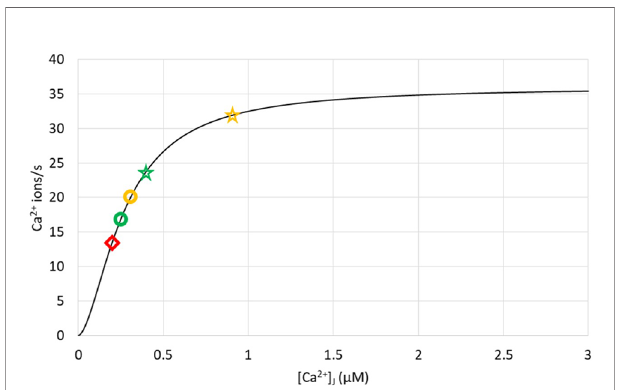
FIGURE 9 | Ca 2+ fl uxes through SERCA pumps in different simulation conditions showing that pumps are not saturated during Ca 2+ microdomains. The curve represents the rate of pumping as a function of cytosolic Ca 2+ , as given by Eq. S19, with C S = 400 m M. Yellow symbols correspond to the opening of the 4 IP 3 Rs nearest to the SERCA, with the circle corresponding to D S = 10 m m 2 /s and the star to D S = 110 m m 2 /s. Green symbols correspond to the opening of the 4 IP 3 Rs furthest from the SERCA, with the circle corresponding to D S = 10 m m 2 /s and the star to D S = 110 m m 2 /s. The red diamond refers to a situation with closed IP 3 Rs, 5 ORAI1 channels of the junction being open as in Figure 2